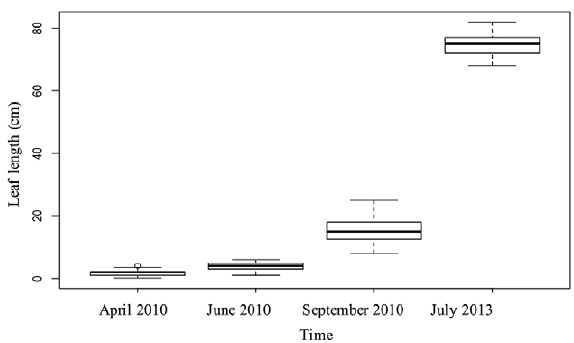
Fig. 4. – Zostera marina meadow leaf length (cm) at Ponta do Adoxe measured after disturbance in four periods from April, 2010 to July 2013.